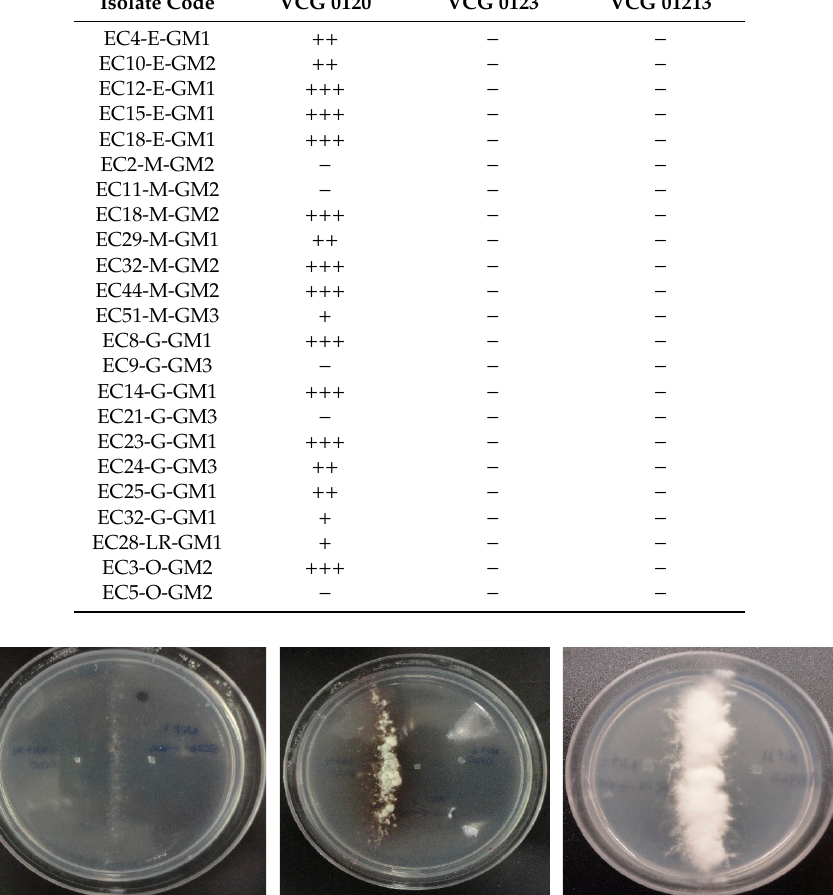
Vegetative compatibility testing after complementation with selected isolates of Fusarium oxysporum associated to Fusarium wilt of banana from Ecuador. The strength of complementation is indicated by “ +++ ”, strong complementation; “ ++ ”, moderate complementation; and “ + ”, weak complementation. “ − “, no complementation.